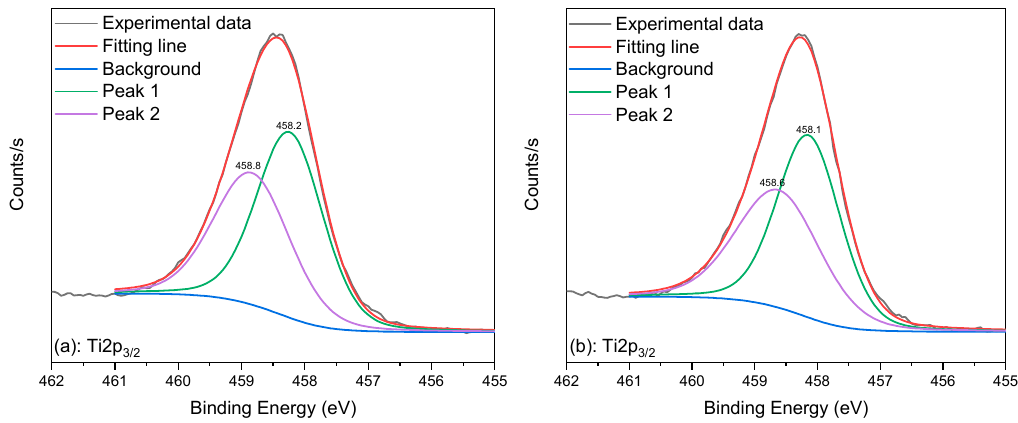
Figure 9. High-resolution spectra of Ti2p3/2: ( a ) pure ilmenite; ( b ) pure ilmenite + BS-12.